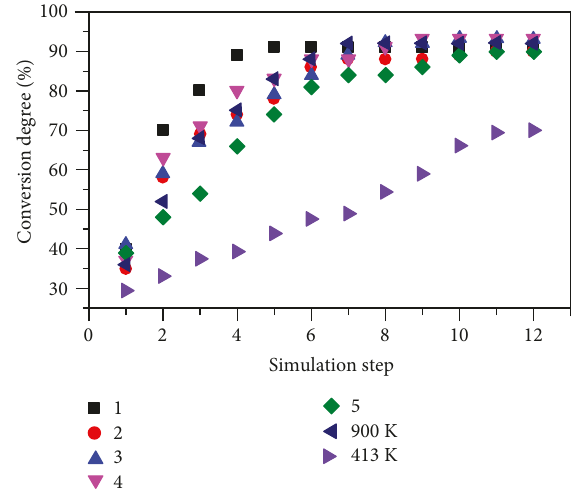
Figure 4: Monitoring of the conversion degree during the multistep cross-linking process for 5 di ff erent boxes equilibrated at 700 K, 1 box equilibrated at 900 K, and 1 box equilibrated at